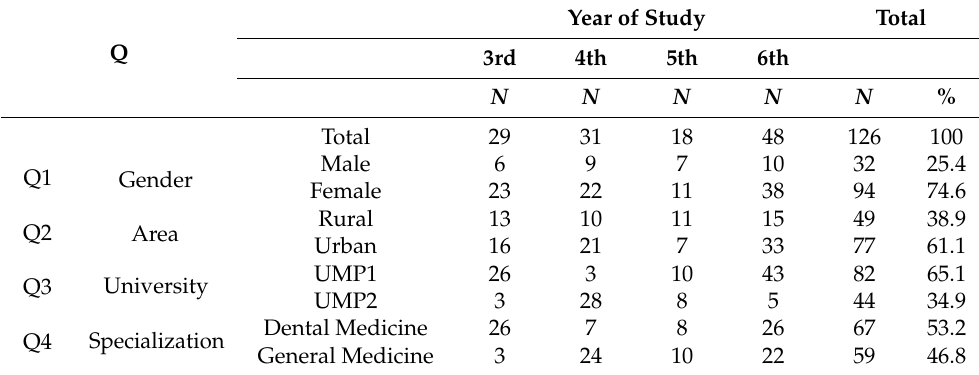
Table 1. General characteristics of the study